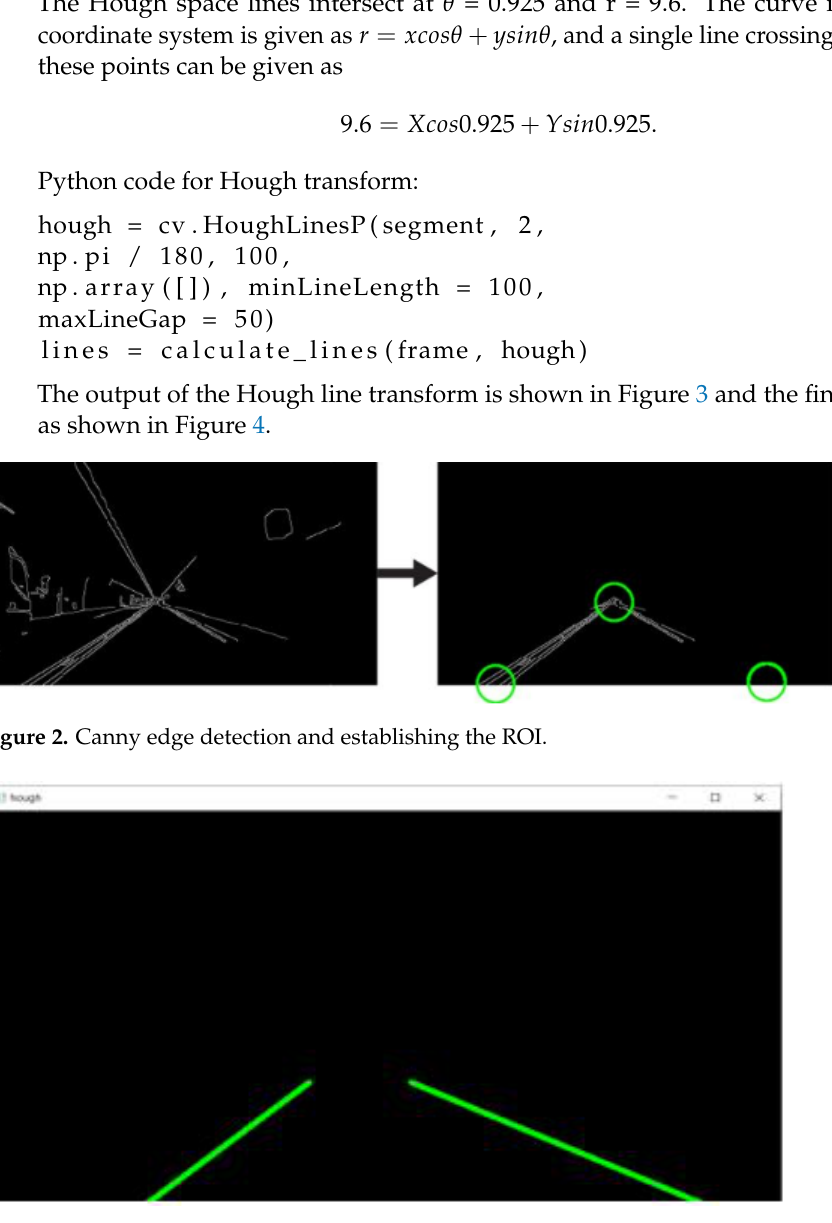
Figure 3. Corresponding Hough line